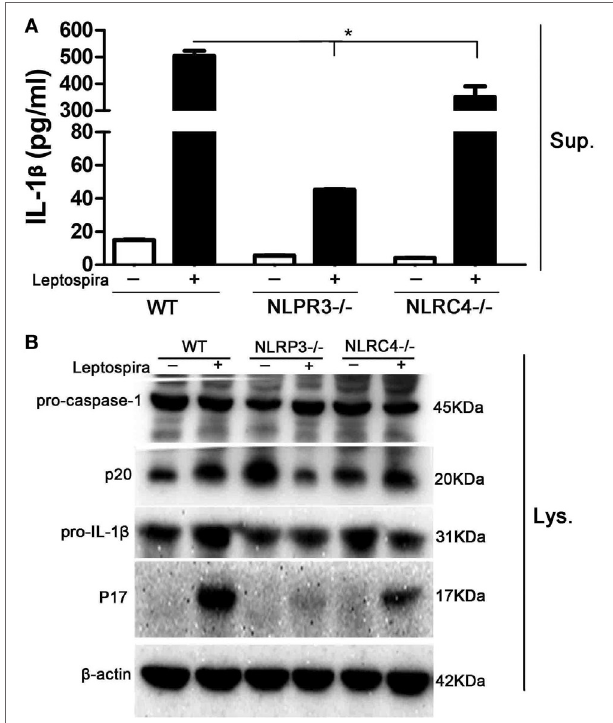
FigUre 3 | Leptospira-induced IL-1 β release was mainly dependent on the NLRP3, not the NLRC4 inflammasome. Peritoneal macrophages were infected live leptospira at MOI of 100. (a) The protein levels of IL-1 β in cell supernatants were measured by enzyme-linked immunosorbent assay. Bars show the levels of cytokines with mean ± SD ( n = 3) and analyzed by the one-way ANOVA. * p < 0.05 vs. leptospira-infected group in wild-type mice. (B) The activation of caspase-1 and the release of mature IL-1 β in peritoneal macrophages extracts (Lysate) were analyzed by immunoblot. The β -Actin protein was used as a